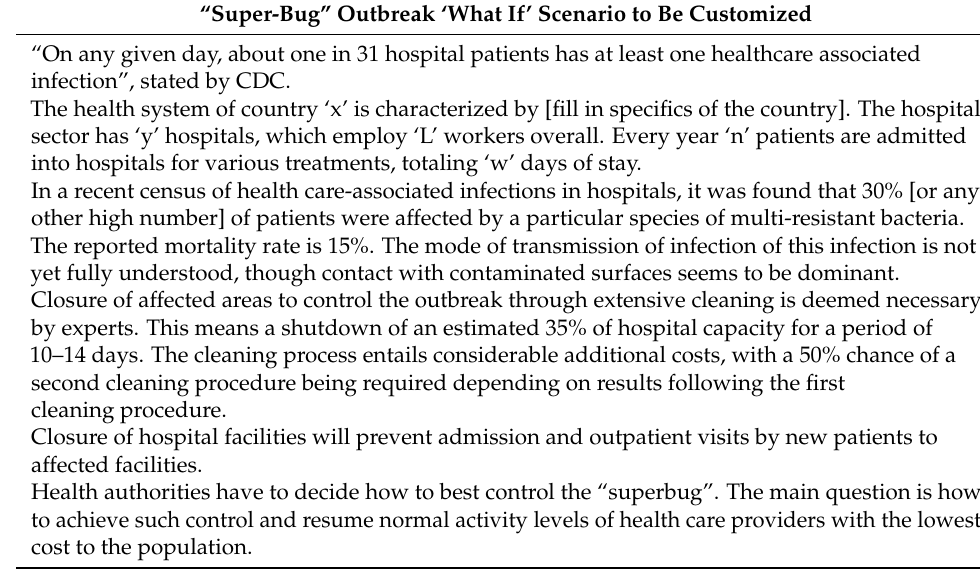
Table 2. Example of basic elements of a resilience test adverse scenario: a “super-bug”